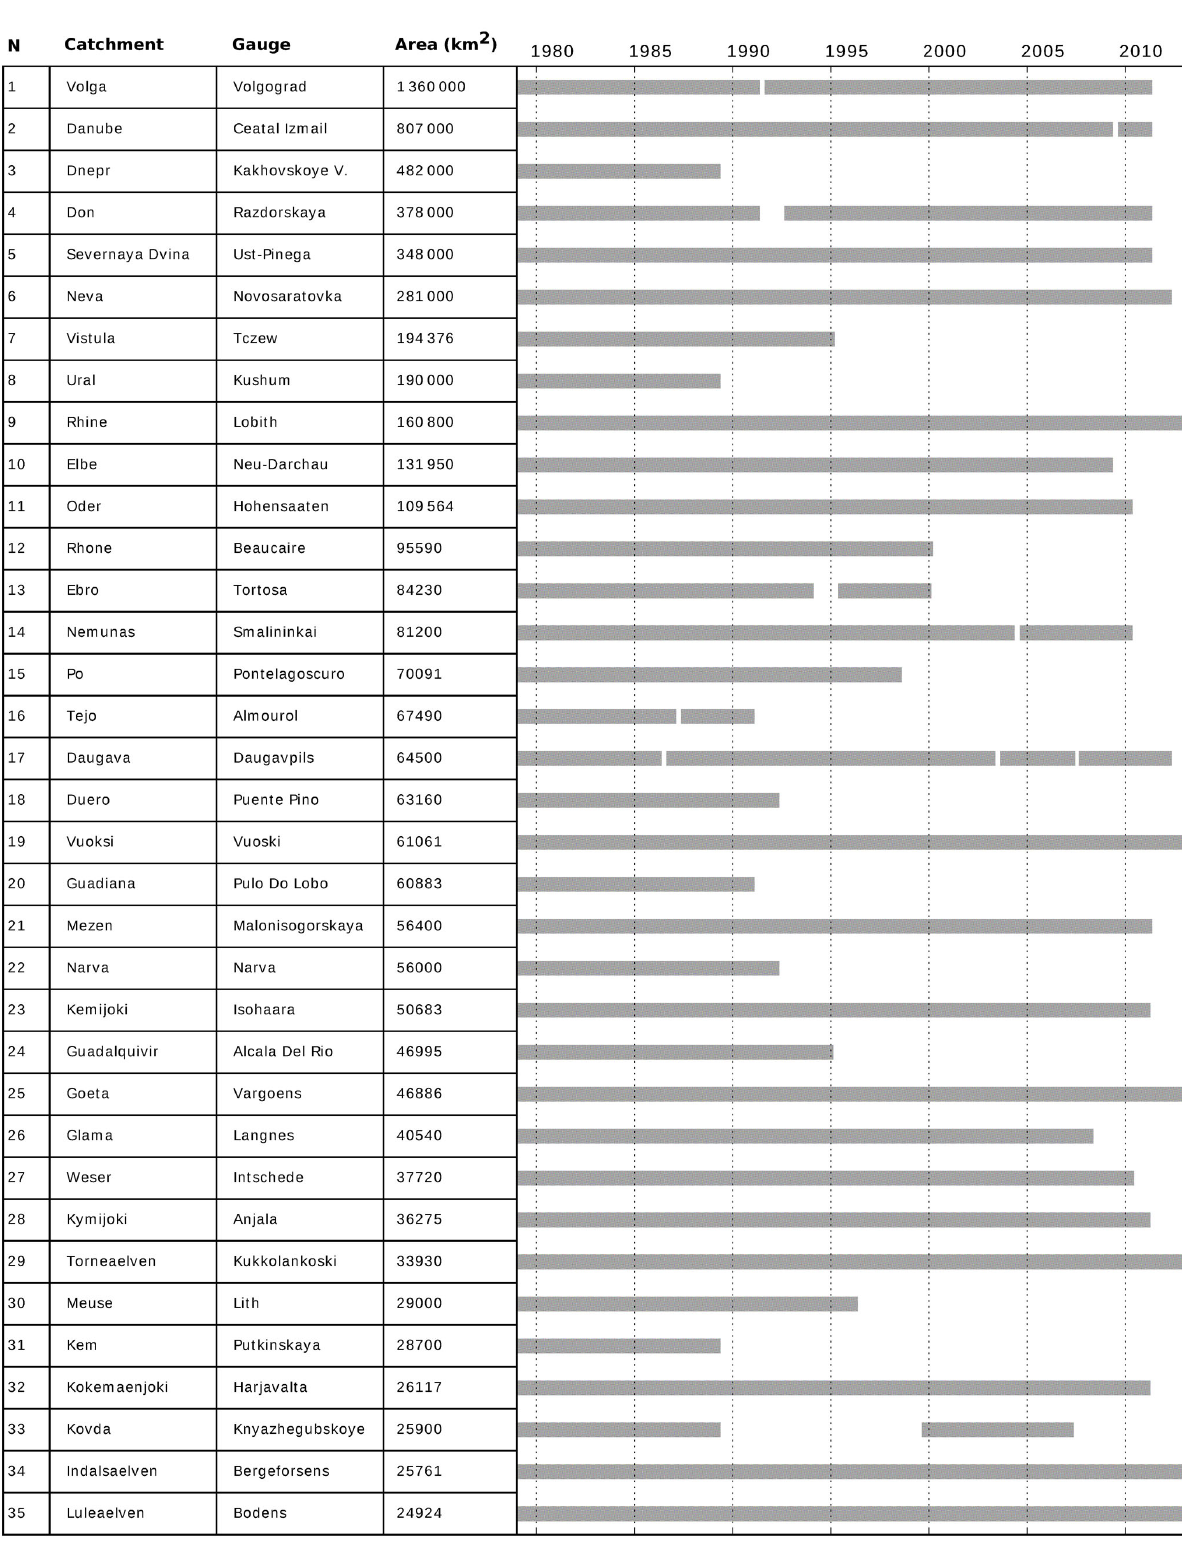
Figure 2. Discharge record availability and drained areas of downstream GRDC gauges. The indices N are mapped in Fig.